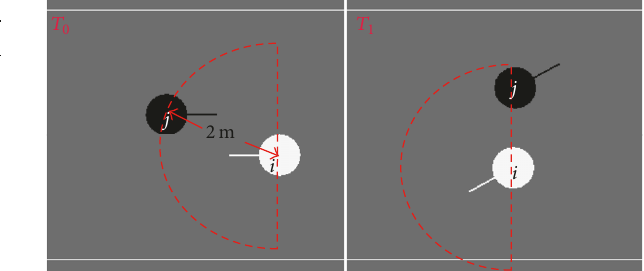
Table 1: Parameters in this simulation.